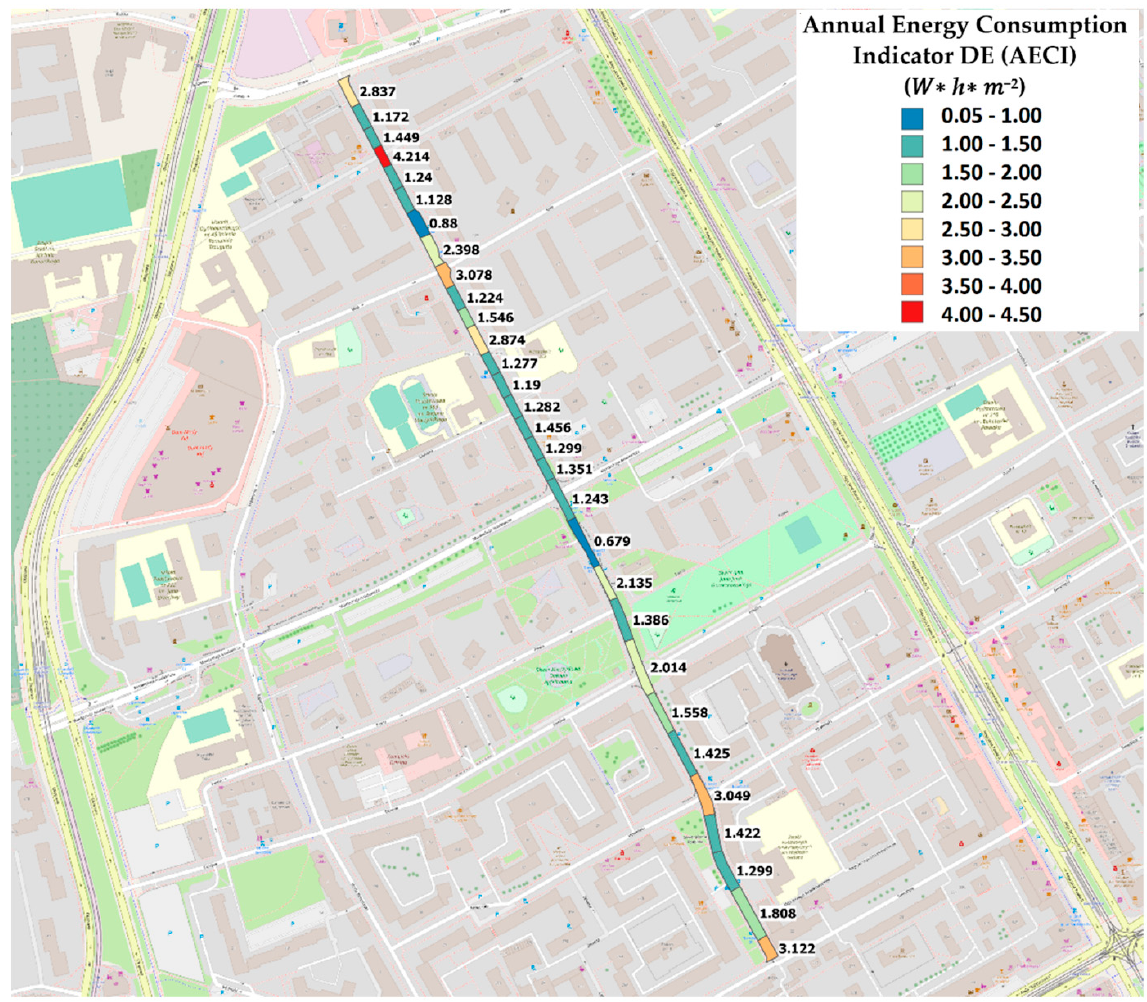
− 2 ) in the calculation field on the